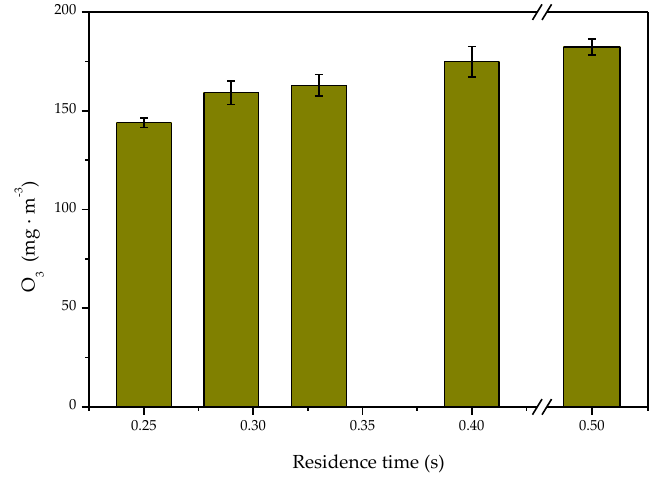
ff ect of the residence time on O Figure 7. Effect of the residence time on O 3 concentration. Figure 7. E